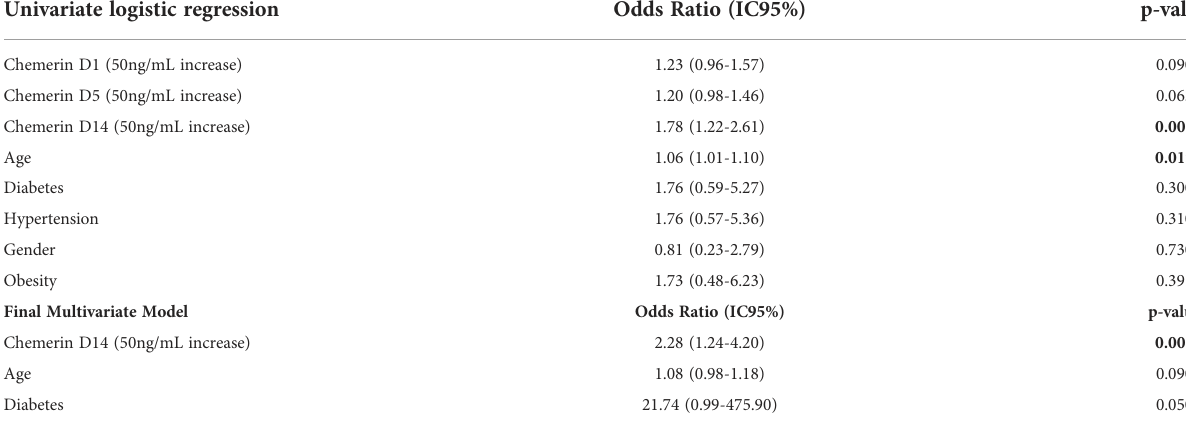
TABLE 3 Risk of death: Univariate logistic regression and multivariate model. Univariate logistic